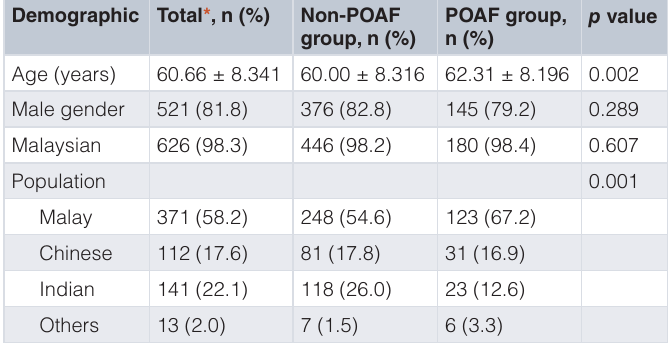
Table 1. Characteristics of the sample population in our study and their association with post-operative atrial fibrillation